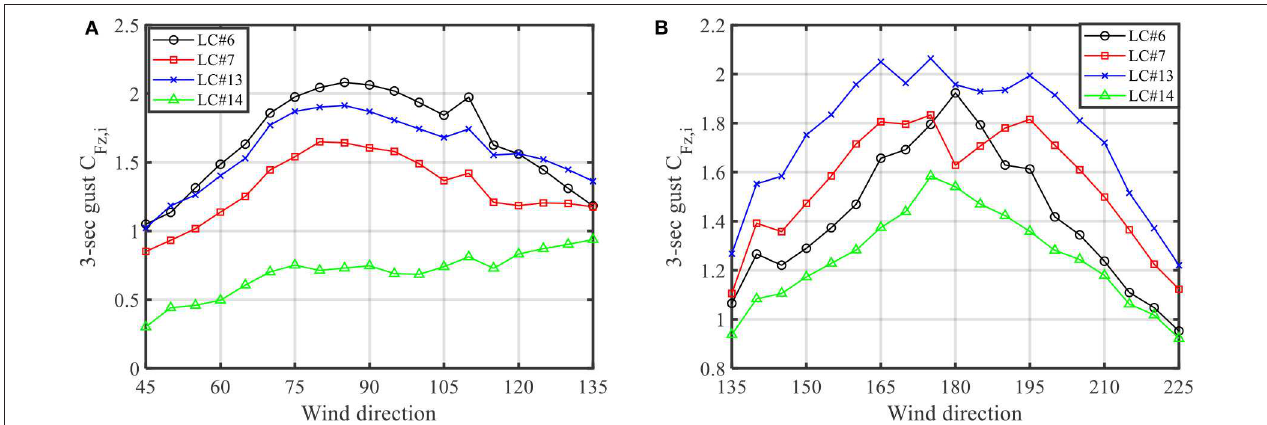
FIGURE 14 | 3-sec gust force coefficients corrected with PTS. (A) Partially enclosed west wall building. (B) Partially enclosed south wall building.